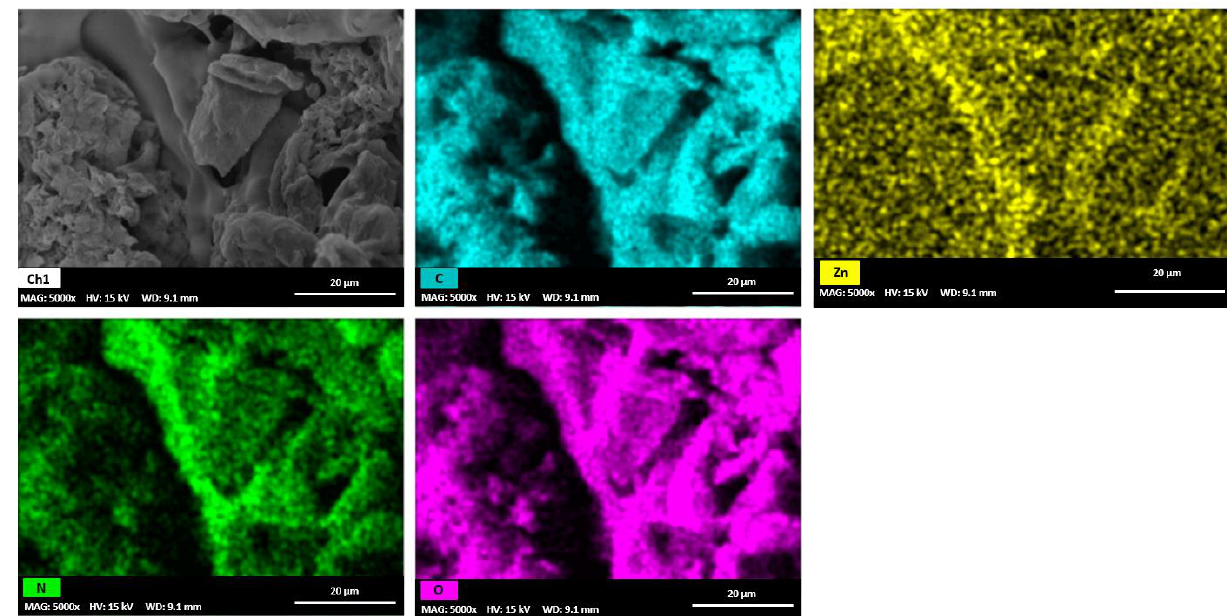
Figure 1. Distribution of elements on CNS-Zn observed with EDS analysis.